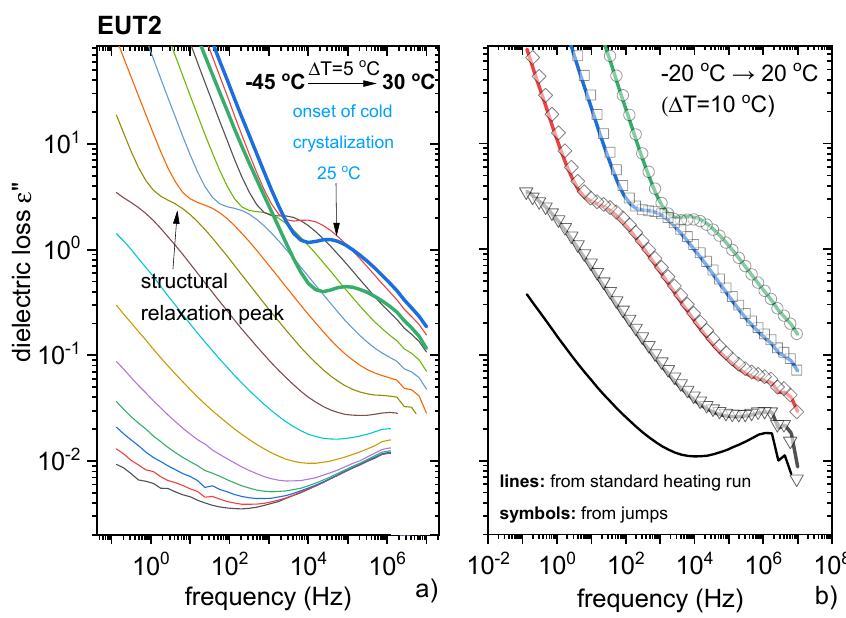
Figure 11. Dielectric studies of EUT2. ( a ) Data recorded on a heating scan. ( b ) Comparison between dielectric spectra of EUT2 measured applying two different procedures (description in text).